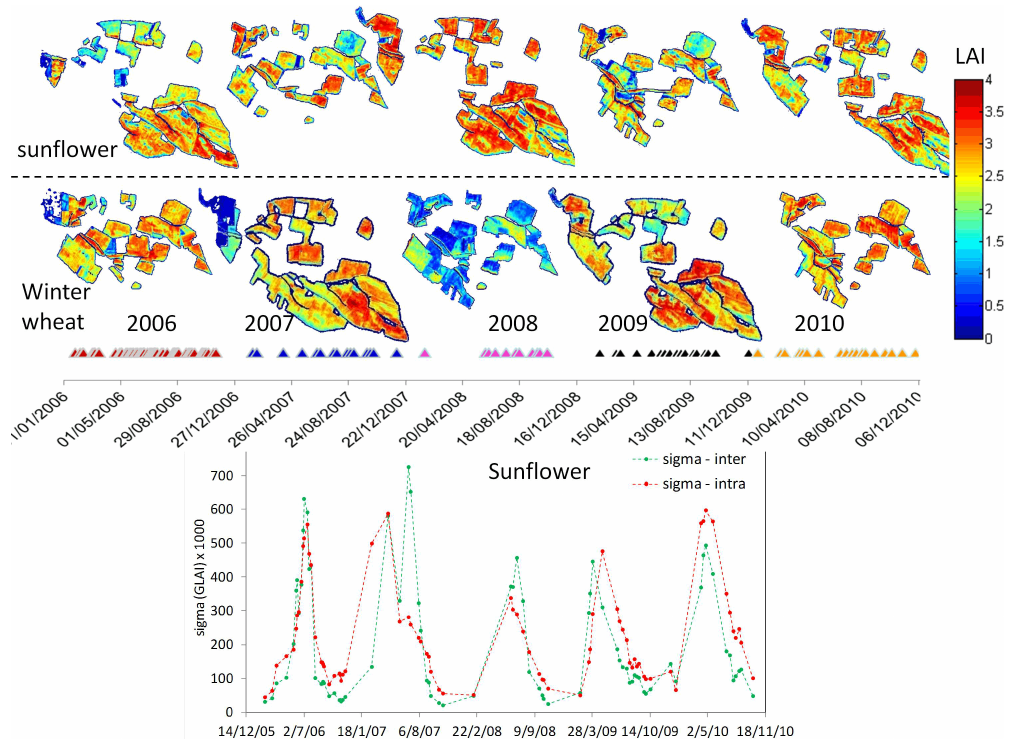
Figure 3. Above: maps of maximum LAI observed for each year and each crop mask. Maxima of winter wheat LAI were not observed during spring 2008 owing to heavy cloud cover throughout the area. Each date of image acquisition constituting the F2 series is indicated by a triangle in the timeline. Below: spatial variability of the LAI as a function of the time between (inter-sigma) and within (intra-sigma) crop-field measurements for